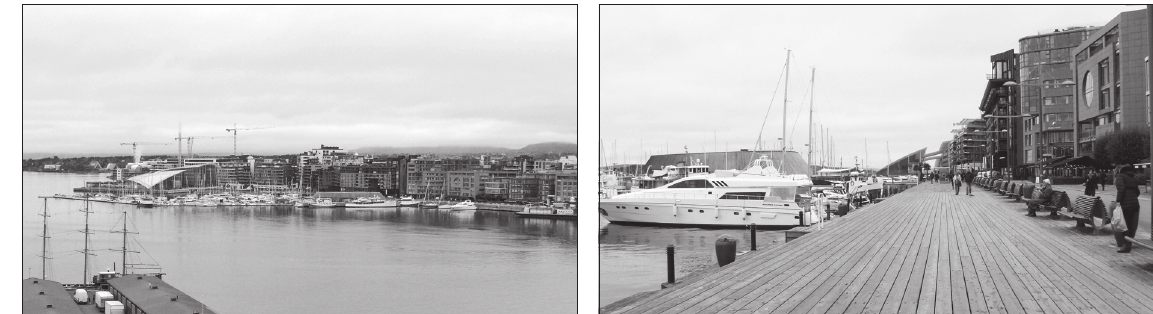
fig. 5. Shipbuilding and engineering zone